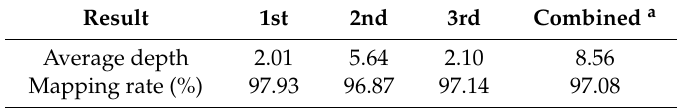
Table 2. Results of average depth and mapping rate for raw reads against reference